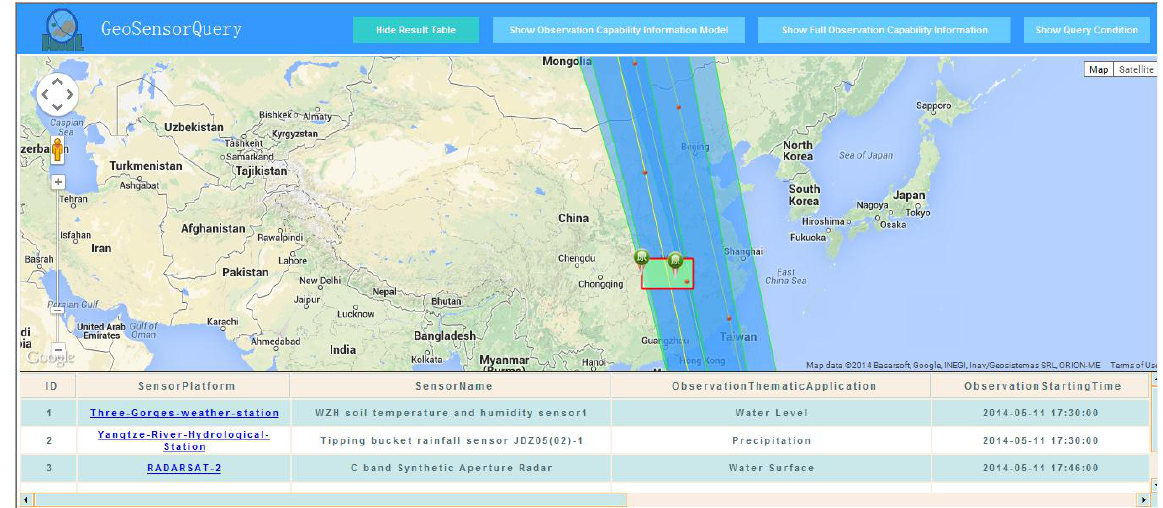
Figure 9. Discovery results of a given geo-event